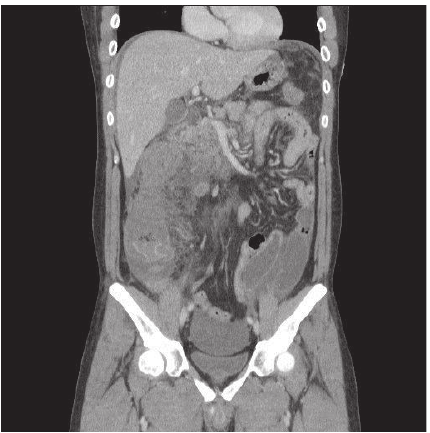
Figure 1: Ascending colon inflammation.